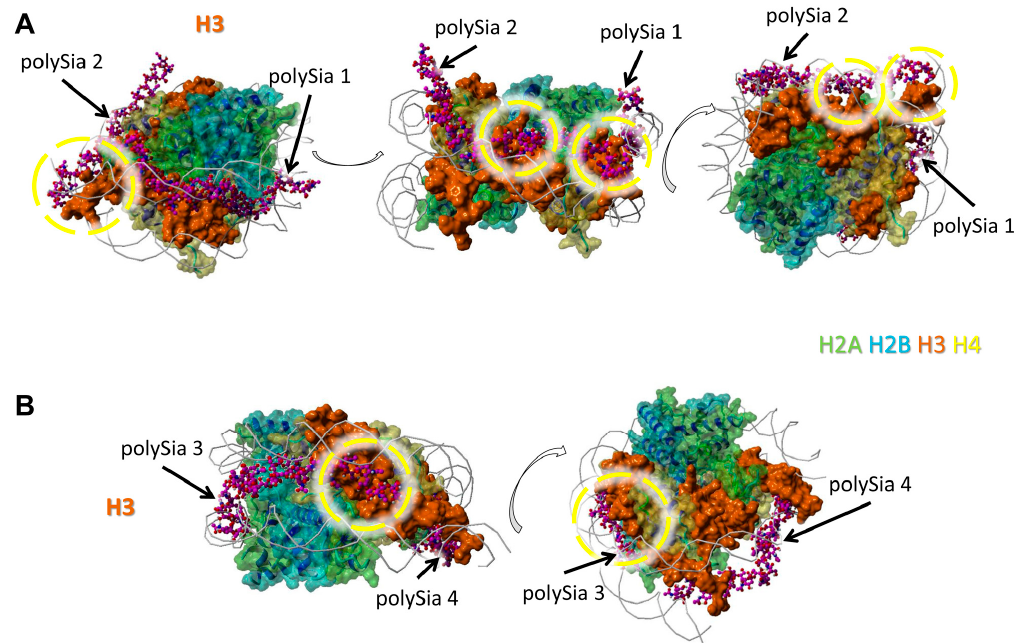
Figure 3. Model of interaction between polySia and H3. The model was generated as described in Figure 1. Color-code: H2A—green, H2B—cyan, H3—orange, H4—yellow, polySia—purple, DNA—gray (as cords). Potential binding areas are highlighted by dashed circles for the histones. The numbered polySia chains are indicated by arrows; ( A ) polySia chain 1 and 2, ( B ) polySia chain 3 and 4. The model is shown from five different perspectives (rotated as shown by the open arrows). H4 seems to interact with two polySia chains in total. The model shows only short distances for directly linked sialic acid residues) and the protein backbone (Figure 4).